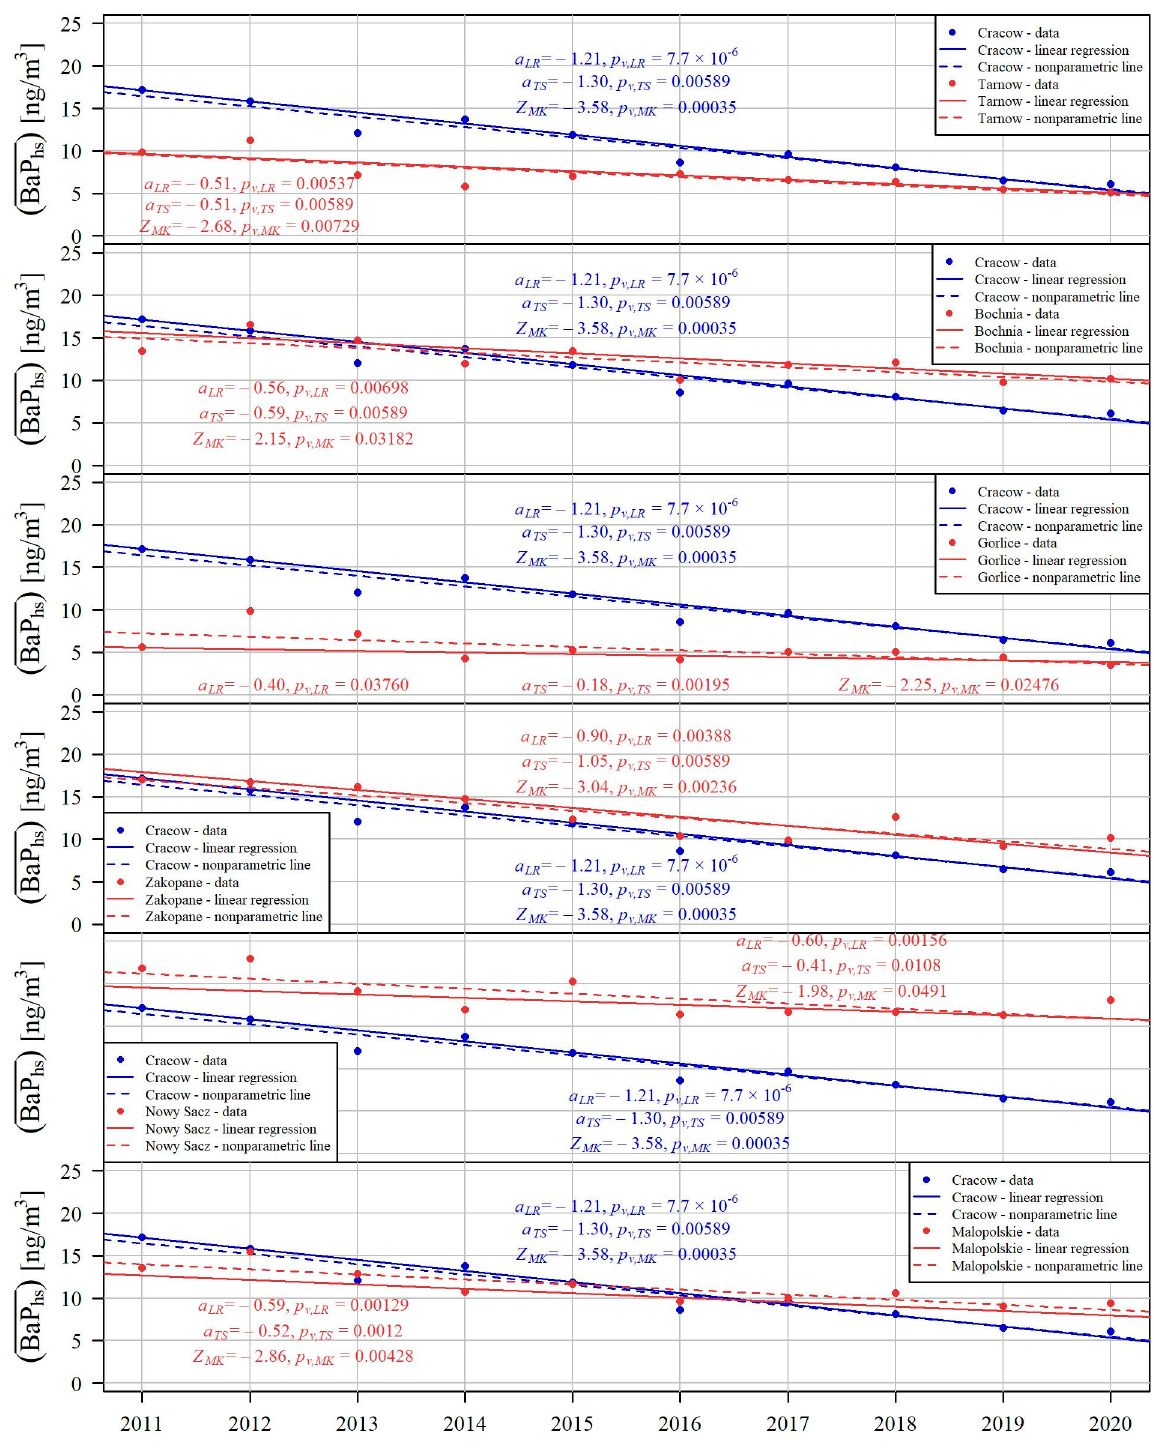
Figure 7. Comparison of the distributions of average annual concentrations of BaP hs (PM10) for the heating season in Cracow and the analyzed cities of the Malopolskie Voivodeship in 2011–2020. Significant ( p v , MK < 0.05) decreasing trends shown using Theil–Sen line with significant slope a TS [ng/m 3 /year] ( p v,TS < 0.05). Linear regressions with significant a LR [µg/m 3 /year] ( p v , LR < 0.05) are shown for comparison. Malopolskie means the arithmetic mean of the values for individual analyzed cities, excluding Cracow. (Source: own elaboration based on the data from the database of the Chief Inspectorate for Environmental Protection [29]).